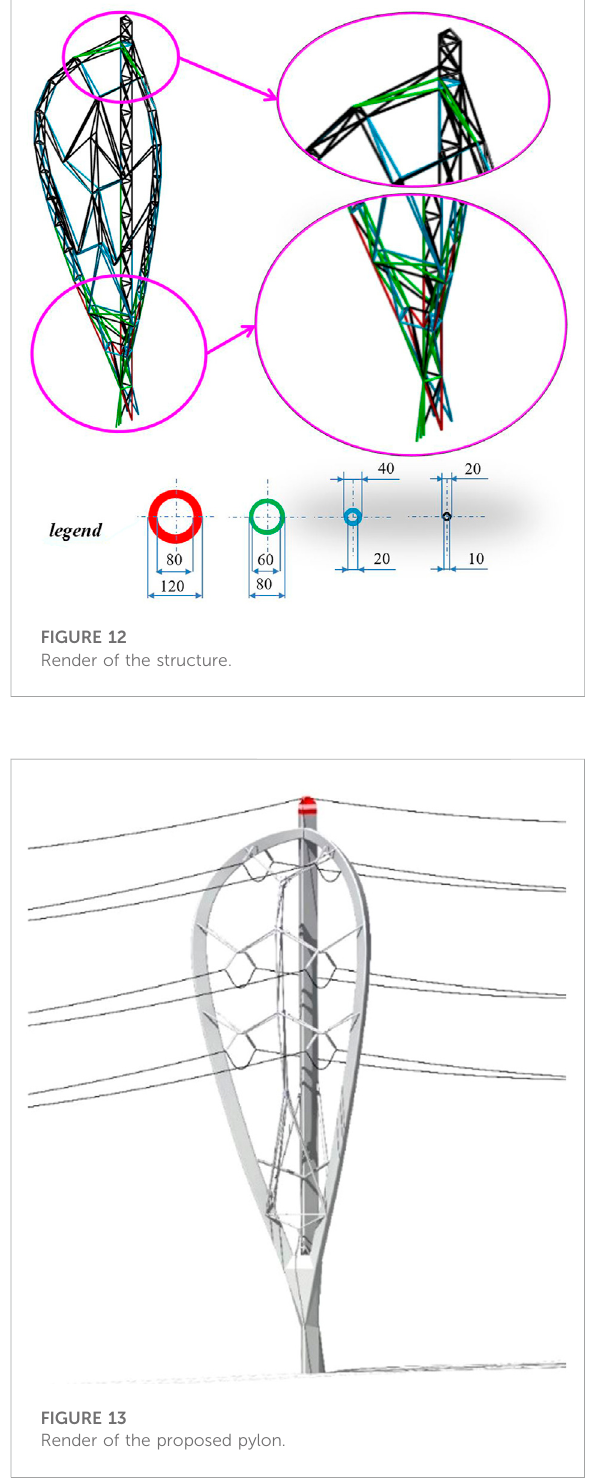
sheet metals are applied to cover the lattice structures of the mast and sail. Figure 13 shows a rendering of the proposed fi nal pylon.